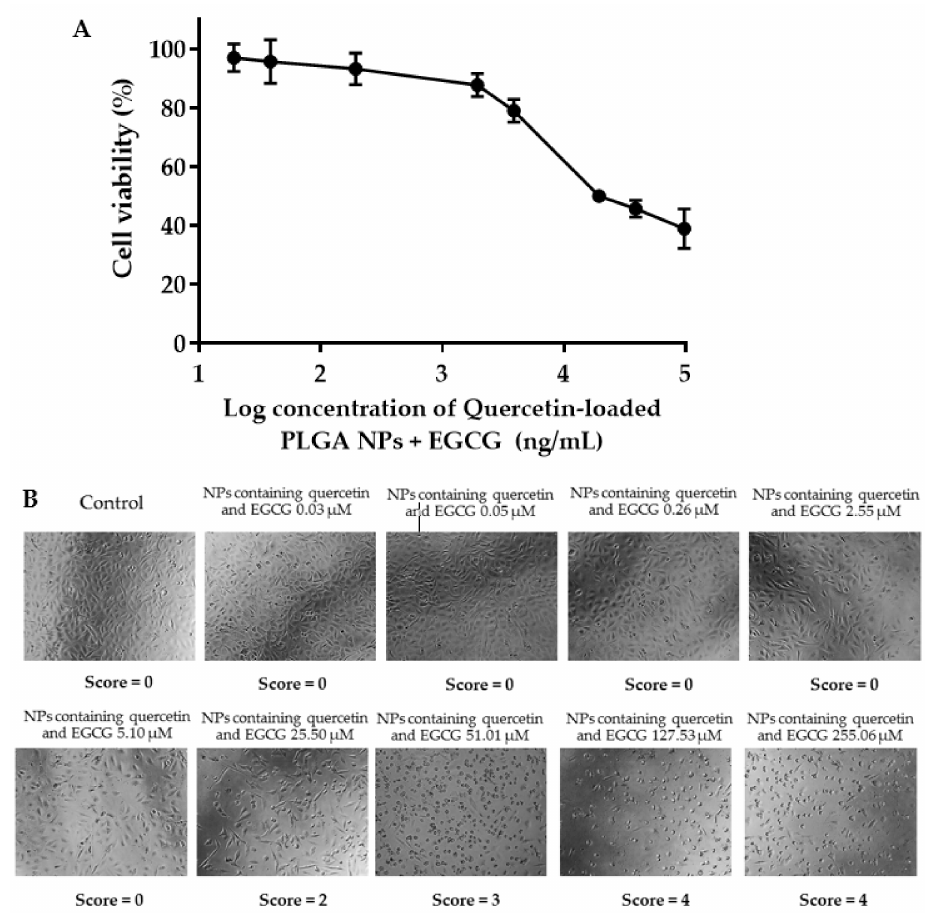
Figure 8. ( A ) Effect of quercetin-loaded PLGA NPs combined with EGCG on the HCE cell viability after incubation for 24 h. ( B ) Changes in the morphology and density of the HCE cells after 24 h of exposure to various concentrations of quercetin-loaded PLGA NPs and